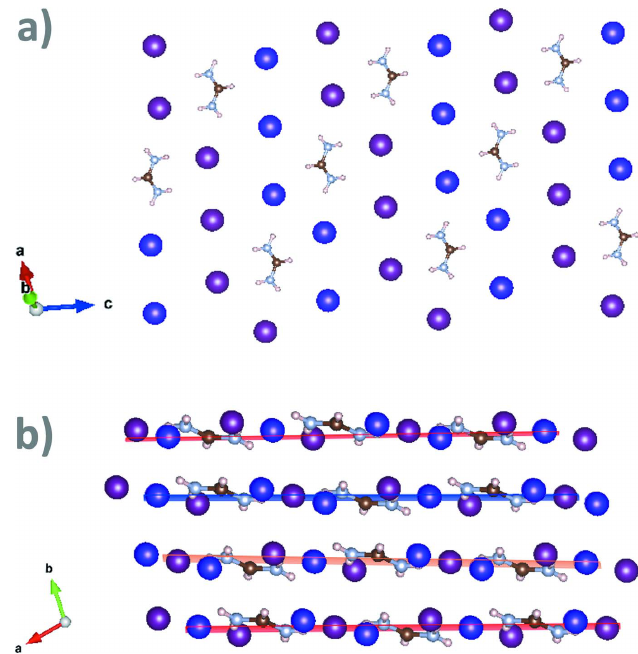
Figure 3 Representation of FAI 3 as a deformed cubic close-packed crystal structure with both iodine and formamidinium units in the close-packing layer. Purple and violet atoms represent positions of iodine from the first and second types of I 3 (cid:3) , respectively. Formamidinium cations are decreased in size for clarity. ( a ) A single close-packed layer and ( b ) representation of FAI 3 as a deformed three-layered close-packed structure (the different types of alternating close-packed layers are shown in red, orange and blue).